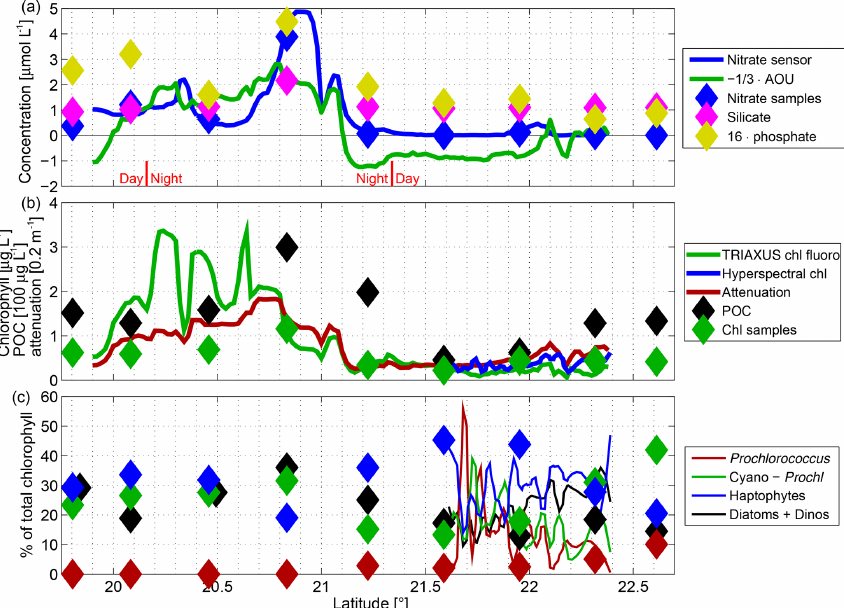
Figure 8. Mixed layer properties with sensor measurements averaged over 0–20m in (a, b) and 0–30m in (c) as lines and samples from 11m as diamonds. (a) Concentrations (in micromoles per liter) of nitrate (blue), − 1 / 3 · AOU (green), silicate (magenta), and 16 · phosphate. (b) Chlorophyll- a concentration (in micrograms per liter) from the fluorescence sensor on the TRIAXUS CTD (green line), samples (green diamonds), and the hyperspectral irradiance sensor (blue), attenuation (0.2m − 1 ; red), and particulate organic carbon (100µgL − 1 ; black). Note the different units used on the y axis. (c) Percentage of total chlorophyll- a accounted for by different phytoplankton functional types: Prochlorococcus (red), cyanobacteria excluding Prochlorococcus (green), haptophytes (blue), and sum of diatoms and autotrophic dinoflag- ellates (black). Lines are from the hyperspectral irradiance sensor and diamonds are from HPLC measurements of underway